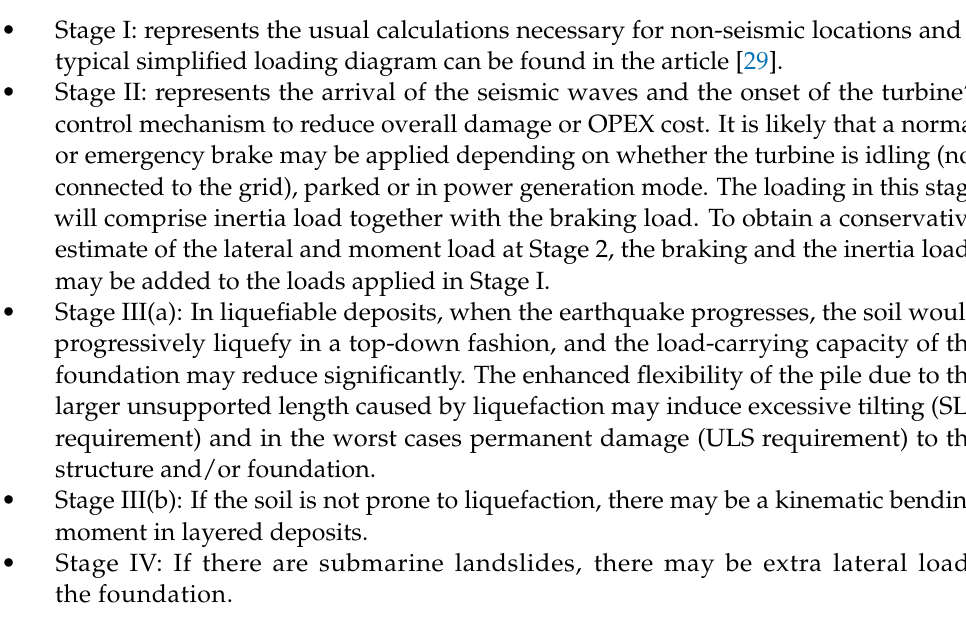
Figure 12. Main loading conditions to be considered for offshore wind turbines in regions prone to seismic events (modified from